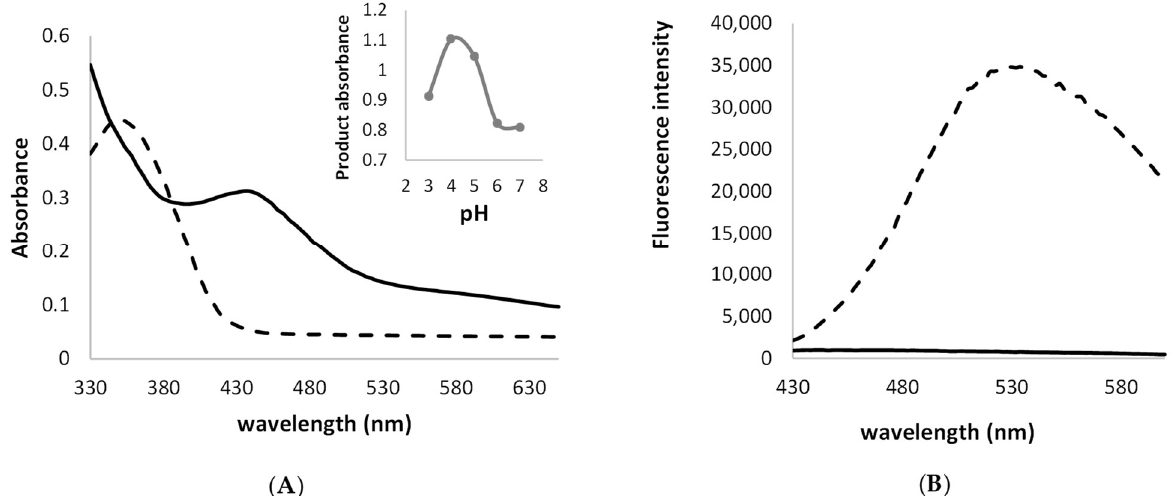
Figure 1. Absorption spectra of the ANS (dotted line) and dye (solid line) obtained at pH 4 after the LAC-mediated ANS oxidation with the optimum pH of oxidation reaction; ( A ) fluorescence spectra ( B ) of the ANS substrate (dotted line) in contrast to the lack of fluorescence of the crude dye obtained after the LAC-mediated oxidation of ANS (solid line) (excitation wavelength of 375 nm). During the optimisation of the dye synthesis, methanol was used as a co-solvent, which allowed for the use of larger amounts of the substrates and thus improved the eco- nomic efficiency of the process. The dye obtained by homomolecular transformation of